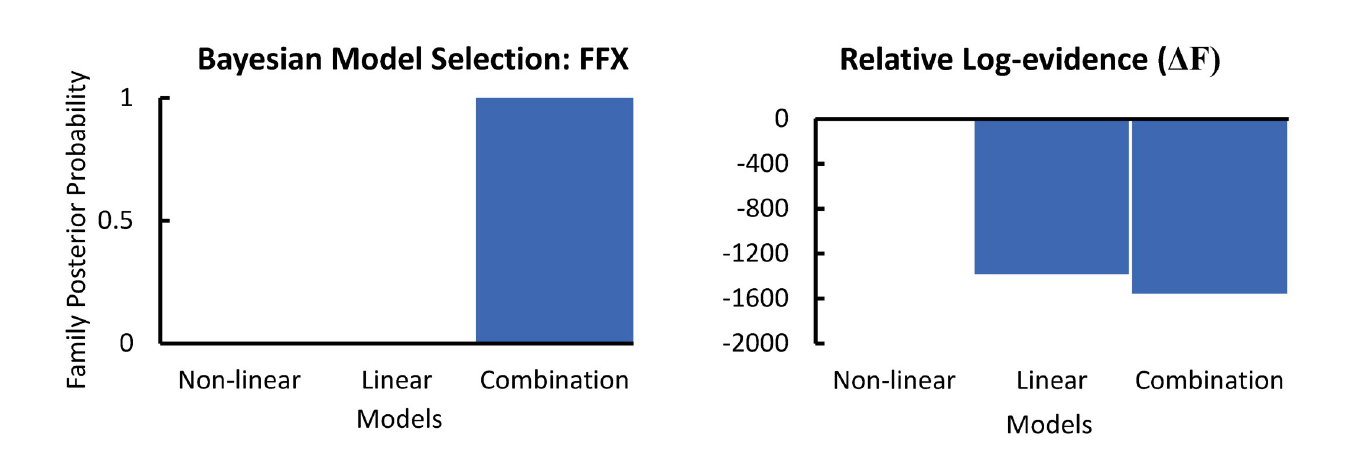
Fig 5. Results of the BMS using FFX demonstrating that a combination of both linear and non-linear effects best describe the data. The next best model represented a difference in log-evidence ( Δ F) between the two highest scoring models of 1382.86 for the linear model, and 1554.79 for the combination model, relative to the non- linear model alone. This indicates > 99% posterior confidence in the winning